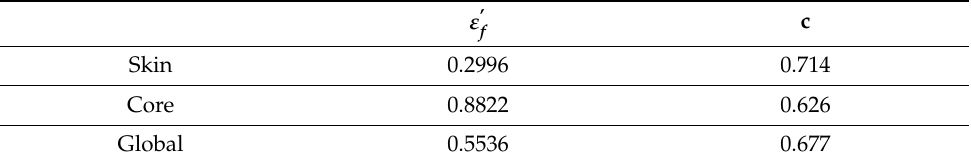
Table 8. Manson–Coffin